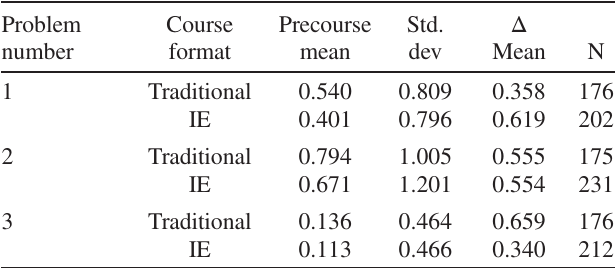
TABLE V. Precourse evaluation scores (and standard devia- tions) and increase in postcourse evaluation scores for sample of IE physics students matched to the traditional physics students on the precourse evaluation scores. ( Δ Mean indicates the average of the difference between each student ’ s pre- and postcourse